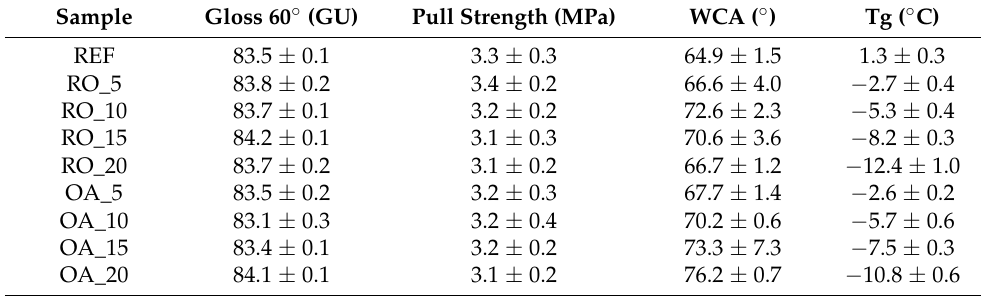
Figure 8. Illustration of the chemical structure of latex polymer composed of copolymerized MMA ( n ), BA ( o ), MAA ( p ), and AME_OA ( q ). Table 6. Coating